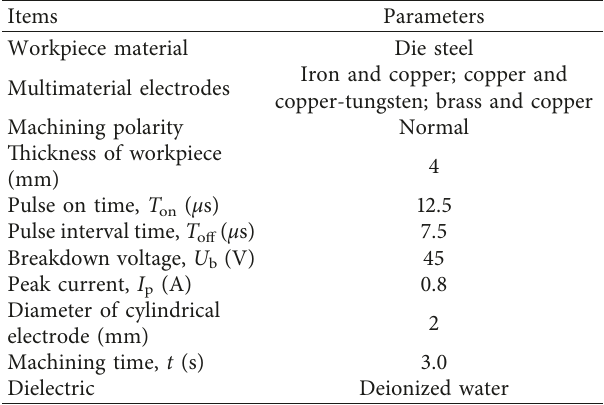
Table 5: Processing parameters of multimaterial electrodes for EDM.